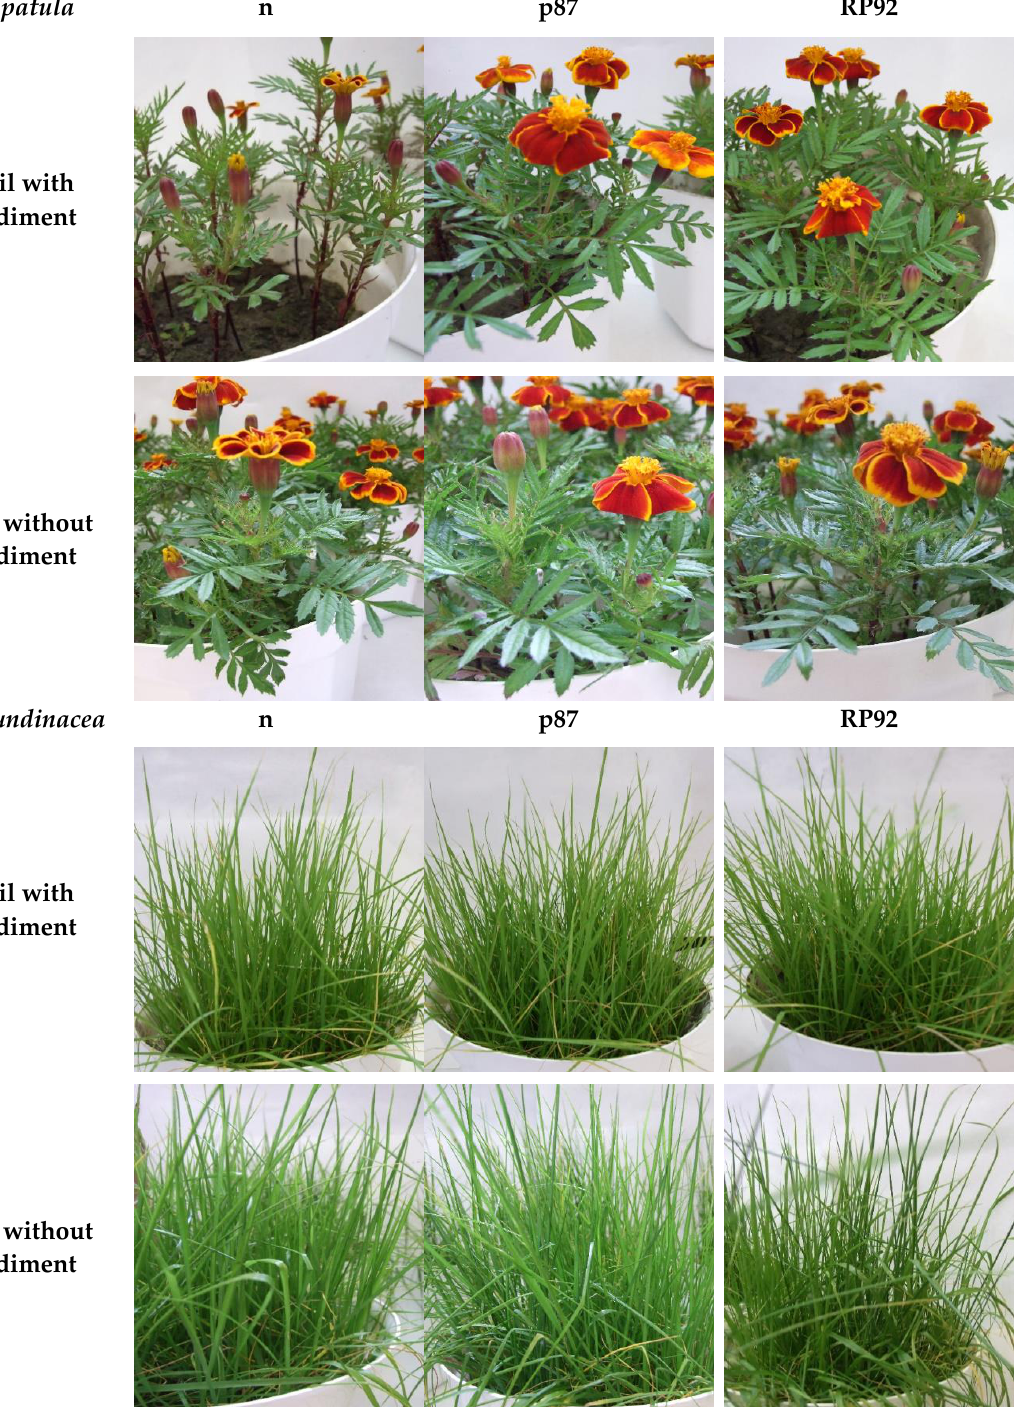
Figure 1. Morphology of 10-week-old T. patula and F. arundinacea plants (just before harvest) grown on control soil and soil amended with bottom sediments, with or without (n) inoculation with bacterial strain p87 or RP92.